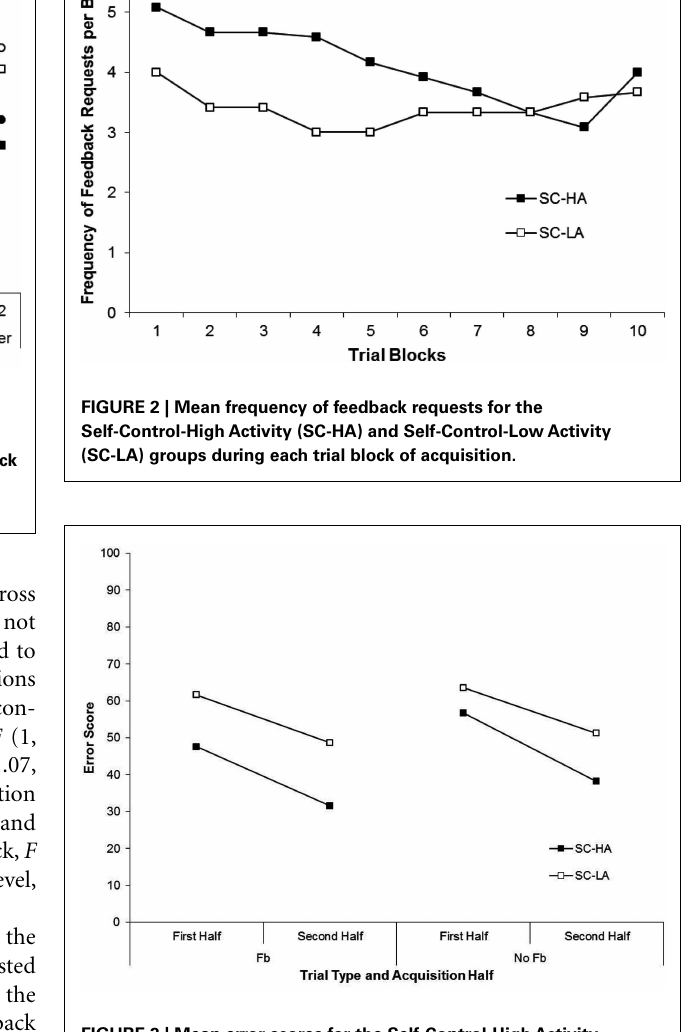
FIGURE 3 | Mean error scores for the Self-Control-HighActivity (SC-HA) and Self-Control-LowActivity (SC-LA) groups as a function of trial type (feedback – Fb vs. no-feedback – No Fb) and acquisition half. A lower score represents more accurate